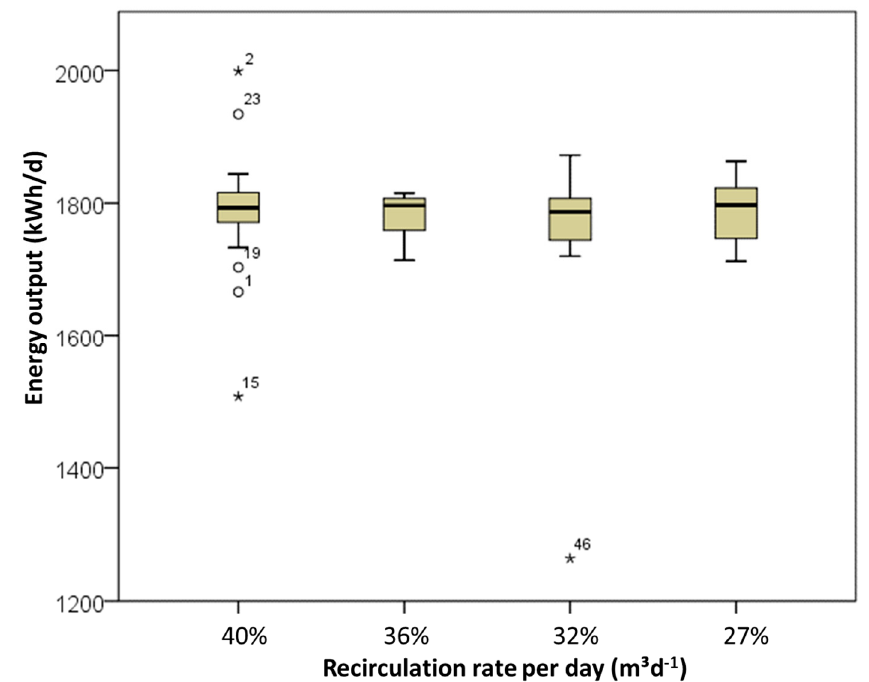
Figure 4. Energy output as a function of recirculation rate ( p < 0.05).